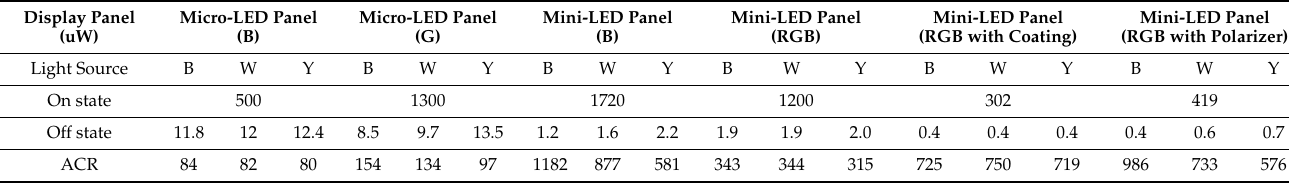
Table 1. Optical measurement of mini-LED and micro-LED panels illuminated by area light source with different reflection